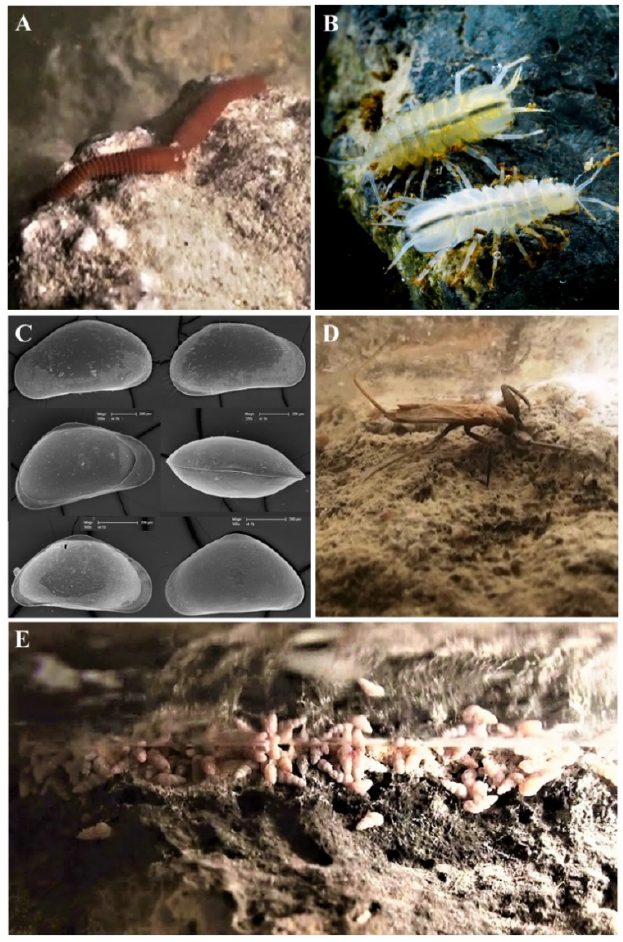
Figure 3. Aquatic invertebrates present in Movile Cave; ( A ). the leech ( Haemopis caeca ); ( B ). isopod crustaceans ( Asellus aquaticus infernus ); ( C ). ostracods ( Pseudocandona sp. nov.), the scale length is 200 µm; ( D ). water scorpions ( Nepa anophthalma ); ( E ). gastropods ( Heleobia dobrogica